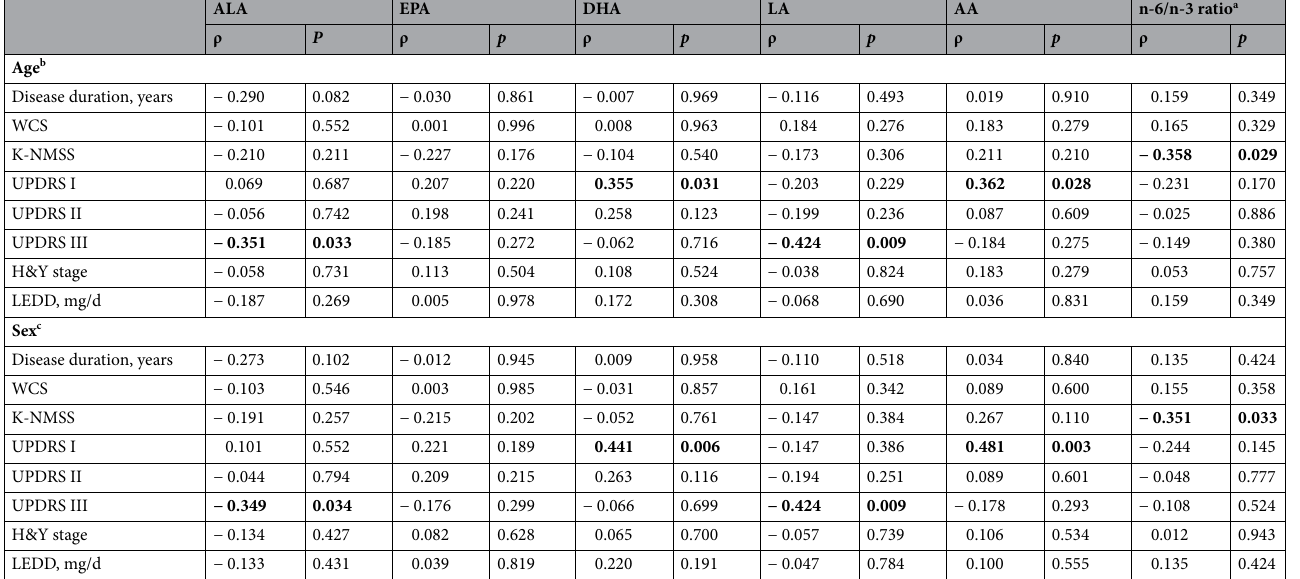
Table 4. Association between clinical parameters and plasma levels of PUFA in PD. Data are described as mean (standard deviation); the correlation coefficients and p values marked in bold indicate statistically significant differences. Spearman’s partial correlation analysis was applied after adjusting for age b and sex c